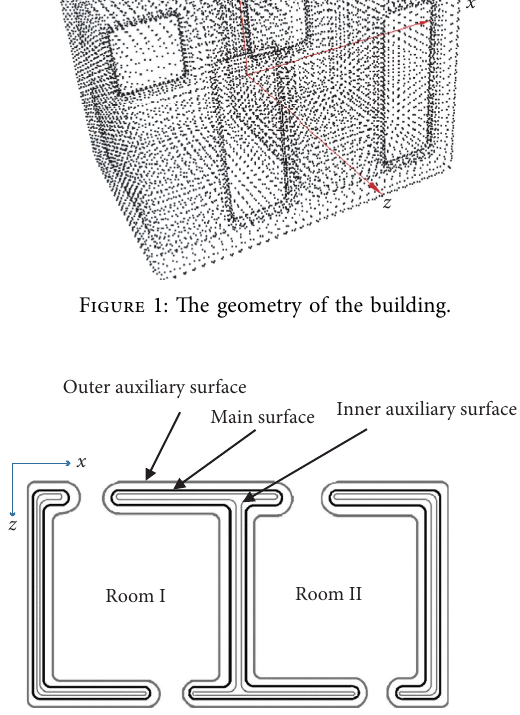
Figure 2: The cross-section ( x - z plane) of the building geometry with inner and outer auxiliary surfaces. Table 1: The dimensions of the